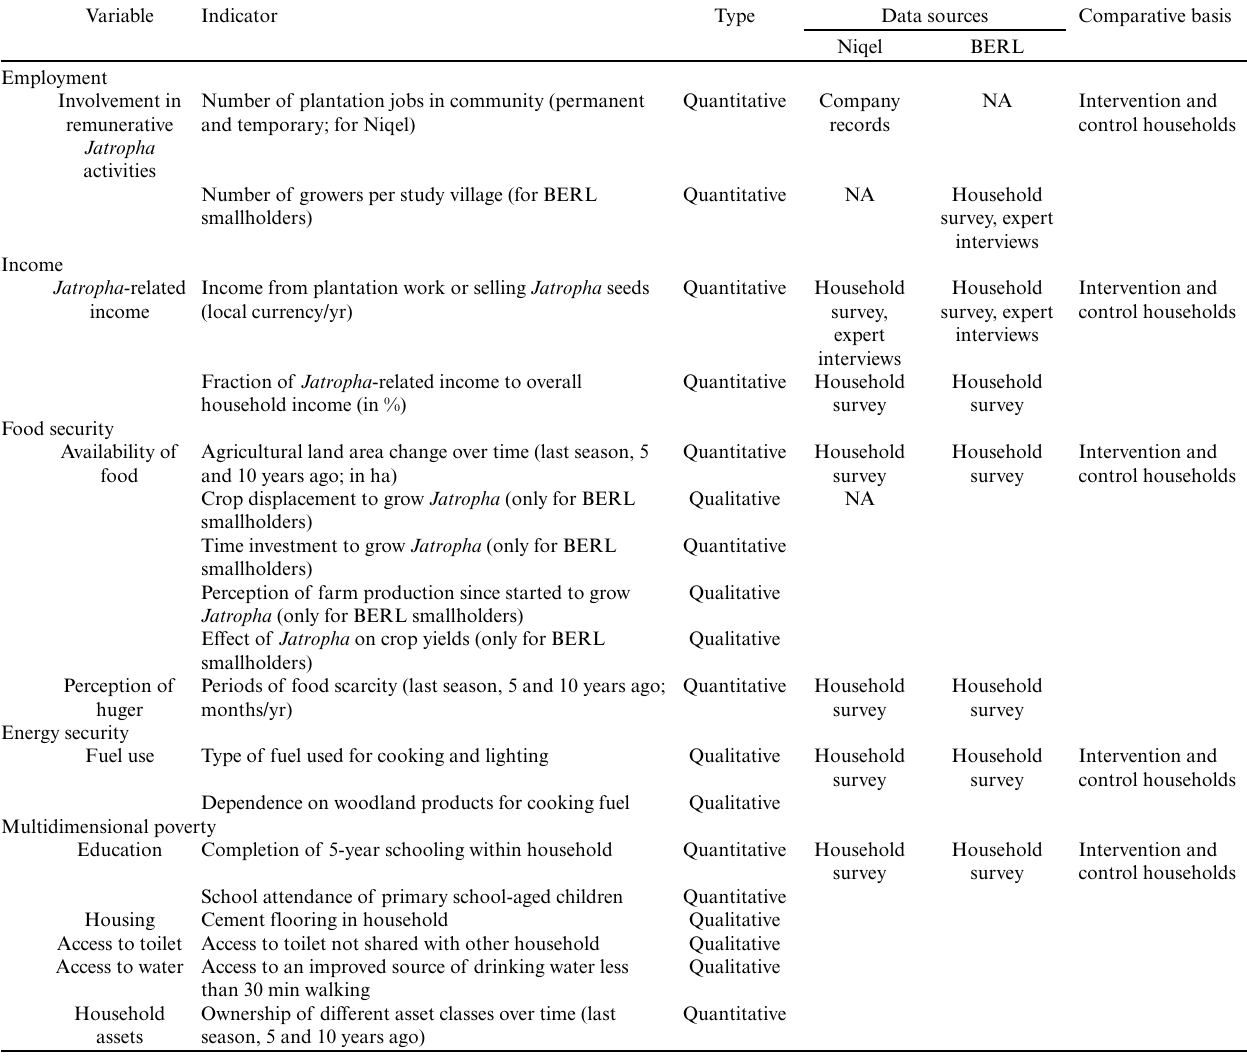
Table 5 . Indicators and data sources for studied components of human well-being and multidimensional